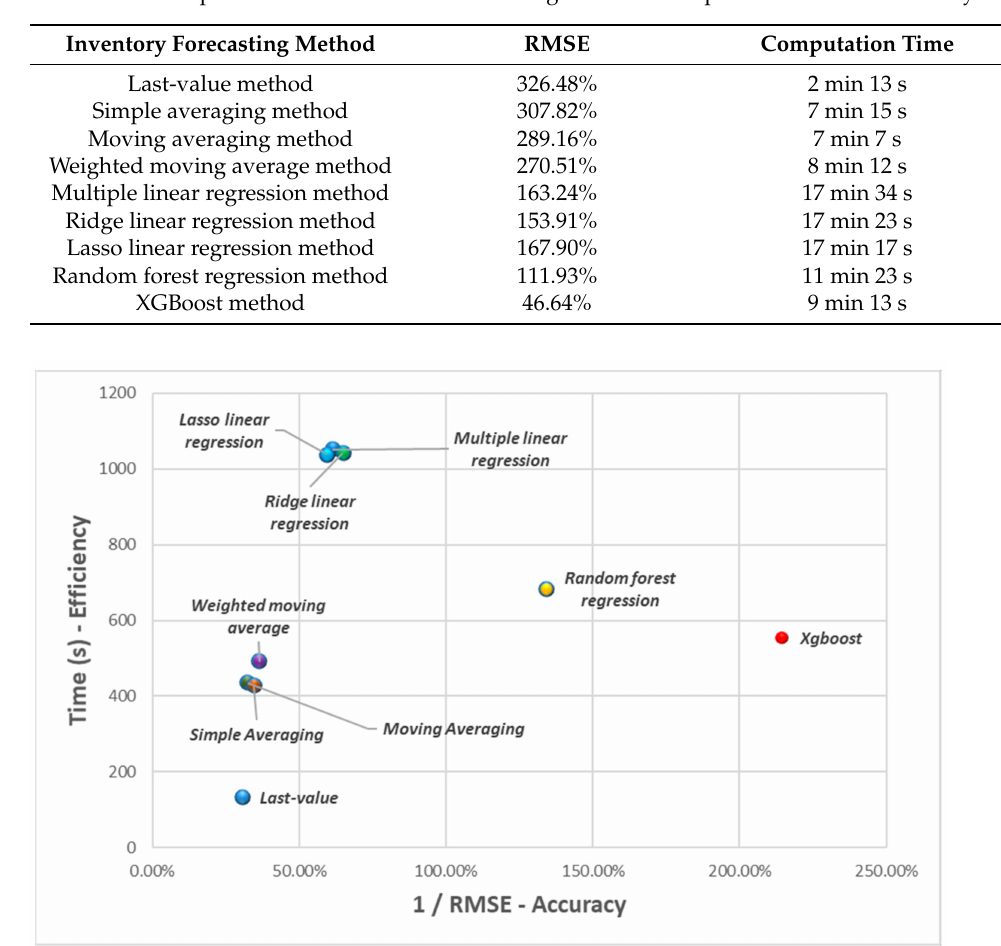
Figure 2. Graphical representation of the computation efficiency and accuracy for various forecasting